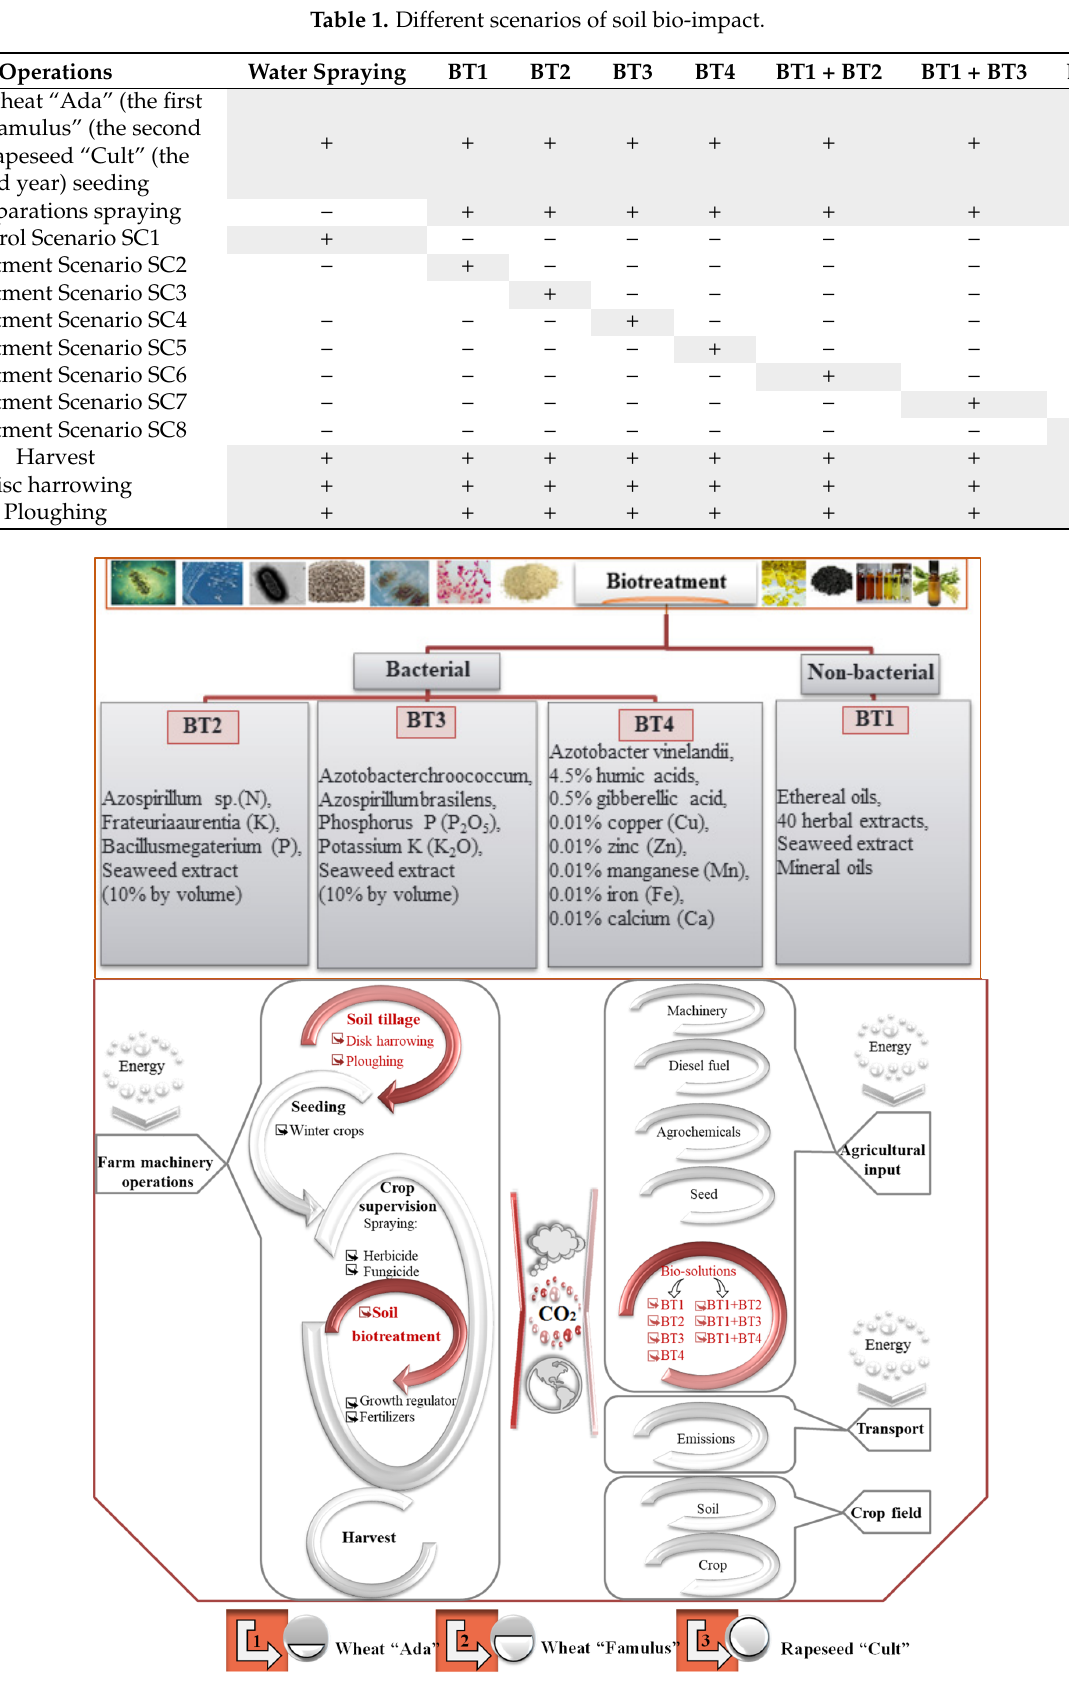
Figure 1. Experimental research design using bio-impact in crop production